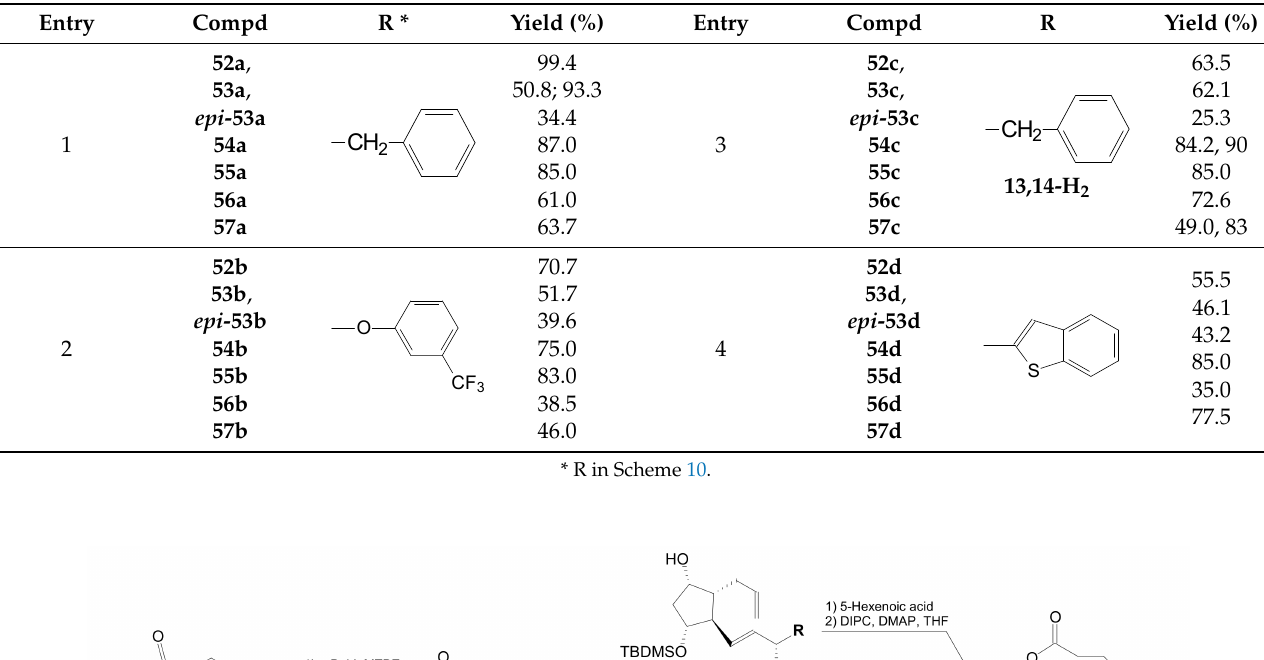
Table 3. Synthesis of 1,9-lactones by RCM [46].